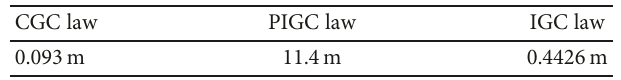
Figure 5: Variable response curves under the three control laws against a moving target. Table 3: Miss distance under the three control laws against a moving target.